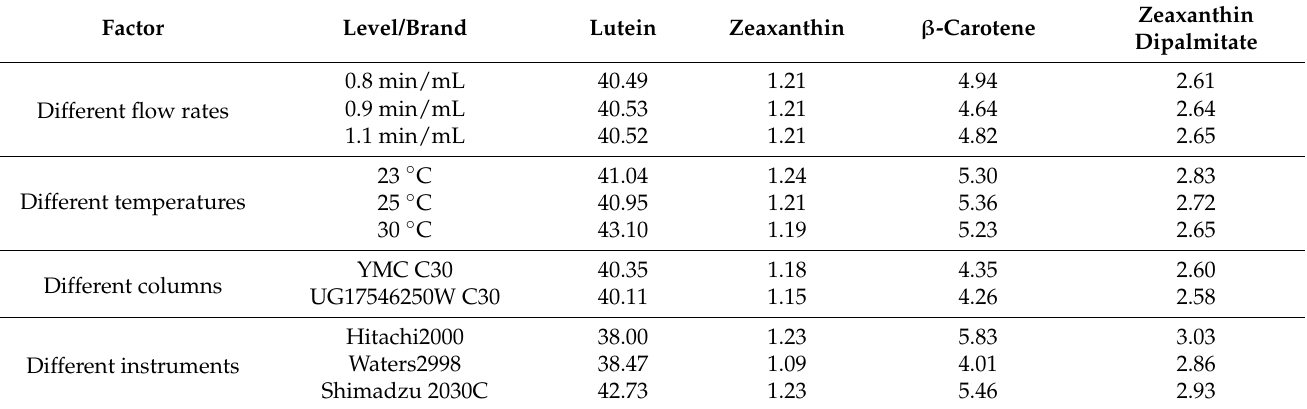
Table 5. The influence of different factors on the value of RCF of each component.